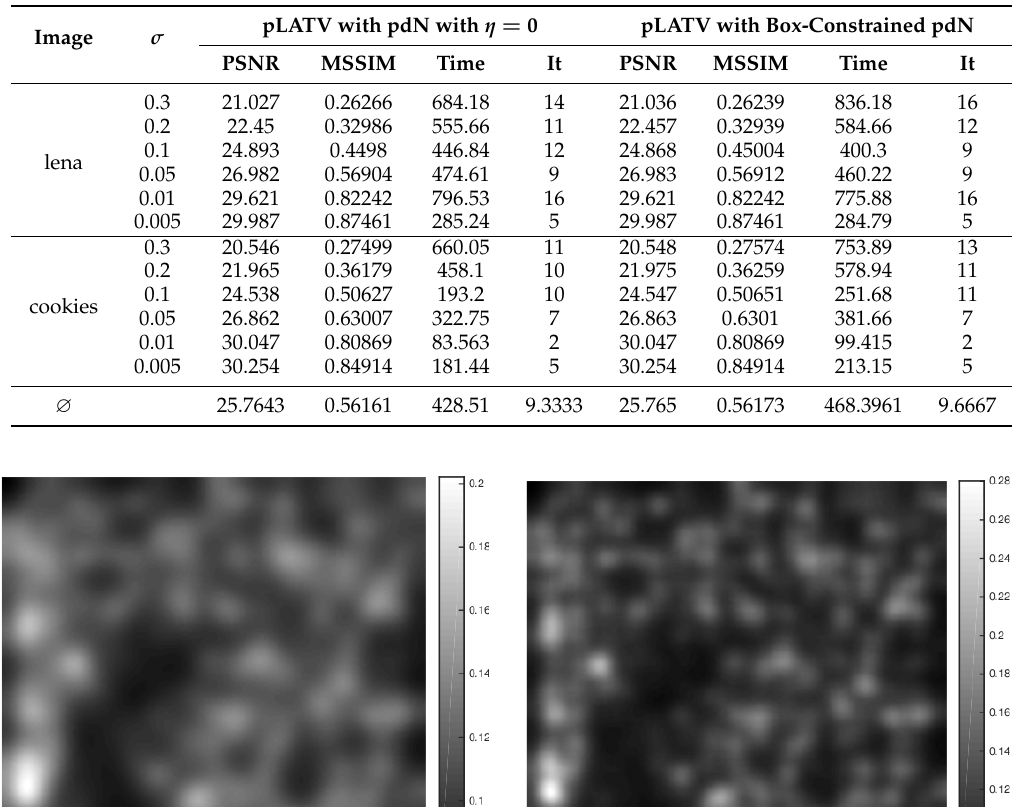
Table 12. PSNR- and MSSIM-values for the application inpainting via pLATV.